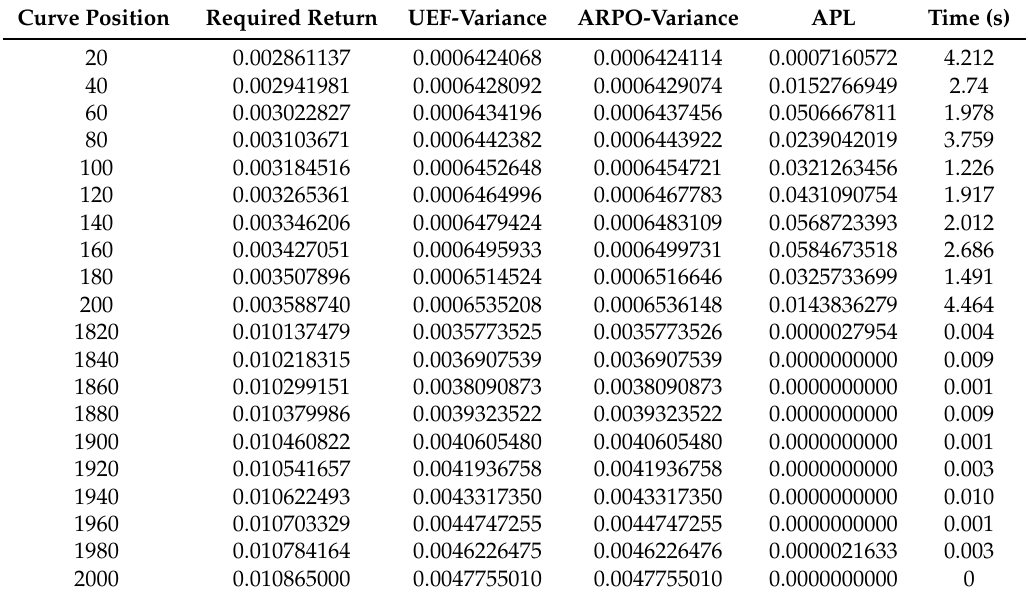
Table 2. Hang Seng Stock Market (Hong